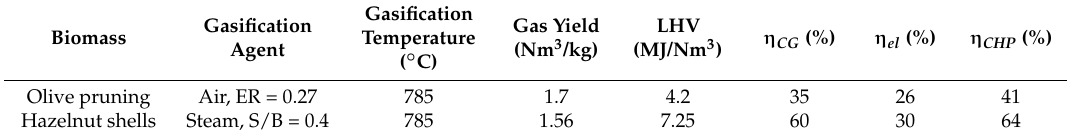
Table 9. Cold Gas, Electrical and Cogenerative efficiencies of the analyzed biomass waste.